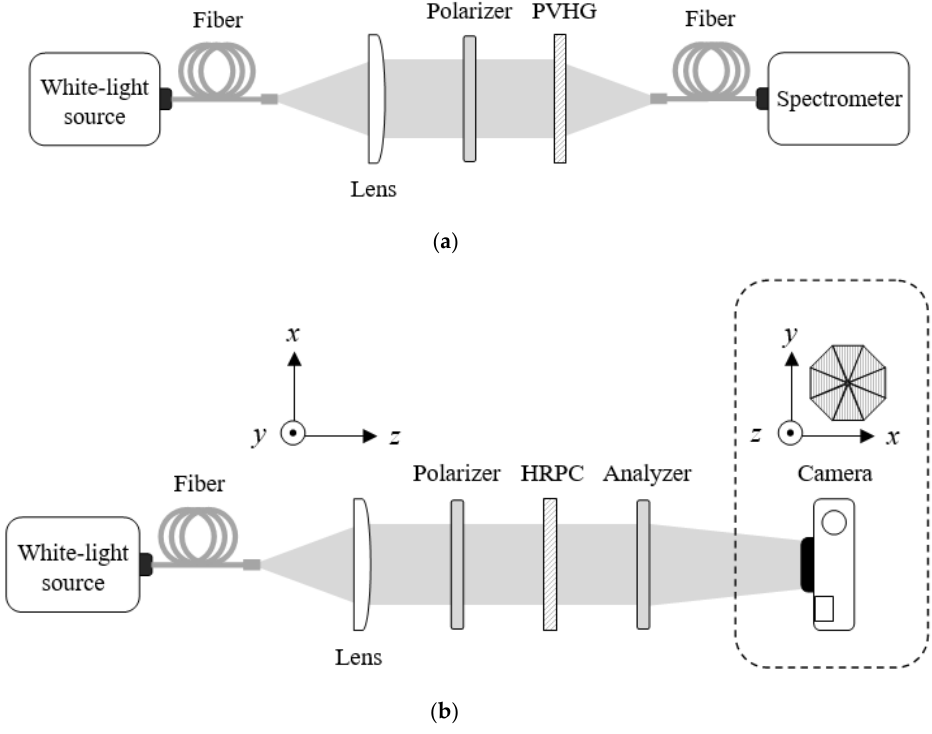
Figure 6. Polarization controlled white-light source testing system for the measurement of ( a ) spectrum diffraction efficiencies; ( b ) light field distributions.